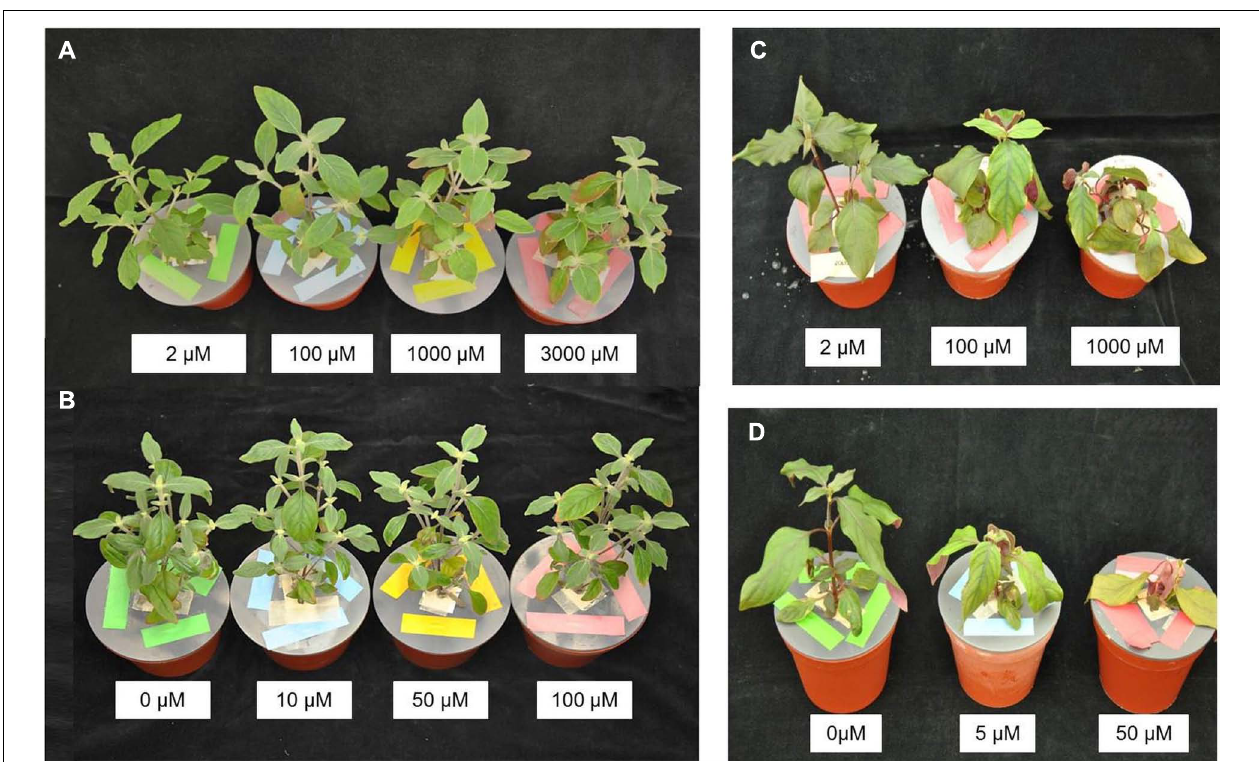
FIGURE 2 | Gomphrena claussenii (A,B) and G. elegans (C,D) plants after 3 weeks of exposure to different concentrations of zinc (Zn) (A,C) and cadmium (Cd) (B,D). Plants are grown hydroponically in half-strength Clark’s